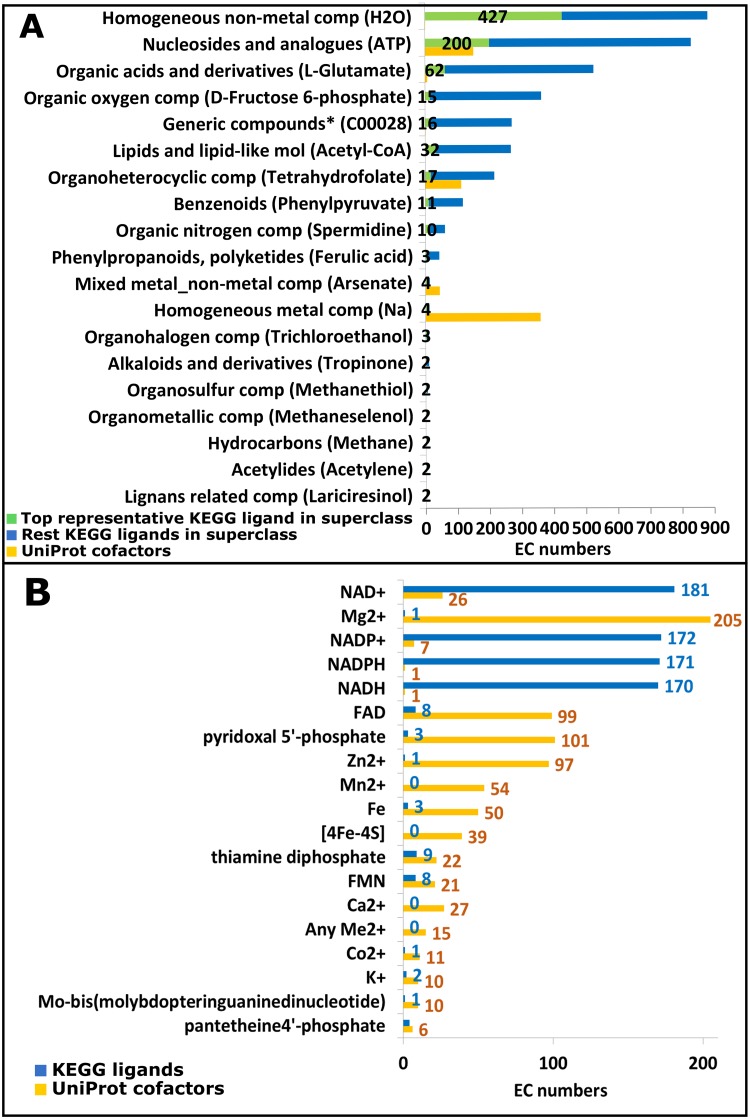
Ligands from RLM catalyzed reactions.(A) ClassyFire superclasses KEGG-defined compounds associated with RLM EC numbers reflect substrates and products of the reaction. Ligands populate 18 out of 31 ClassyFire superclasses and one additional unclassified group (marked by *). (B) UniProt KB and KEGG distinguishes RLM associated cofactors (41 organic and inorganic cofactor compounds. Top 19 compounds are shown).